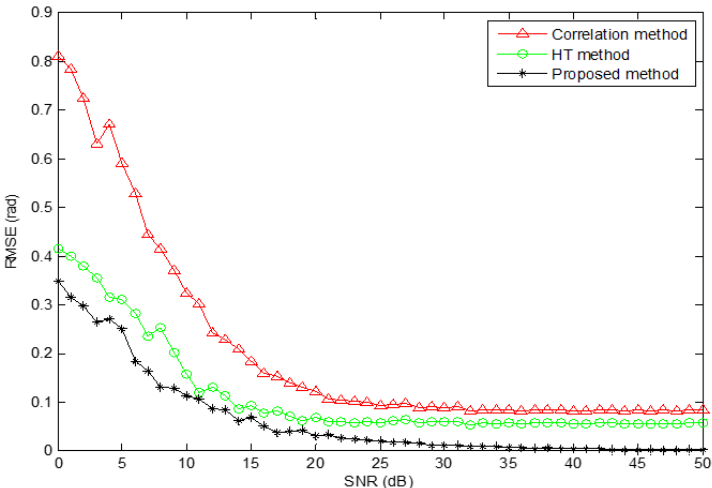
Figure 3. RMSE comparisons with different SNRs.